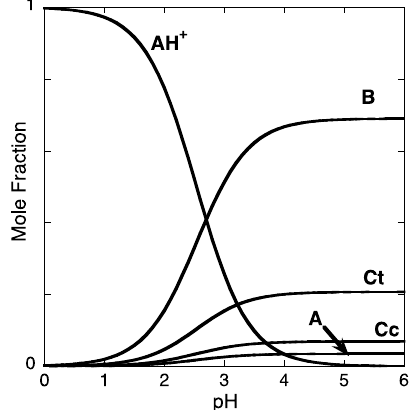
Figure B1. Mole fraction distribution for the following set of equilibrium constants K a = 10 − 4 M; K h = 2 × 10 − 3 M; K t = 0.1; K i = 3 ( K (cid:48) a = 2.9 × 10 − 3